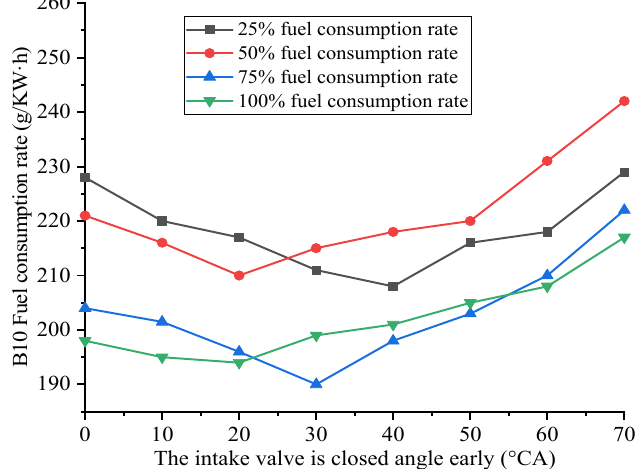
Figure 15. The effect of fuel consumption when Miller degree > 0.